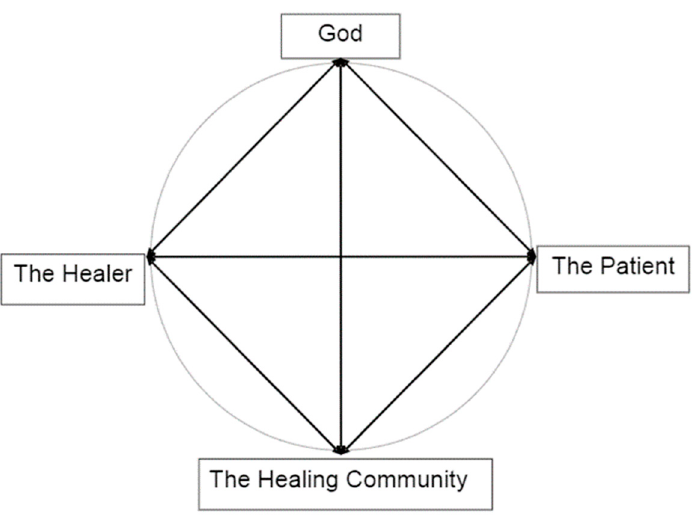
Figure 1. The Healing Wheel in Holistic Health